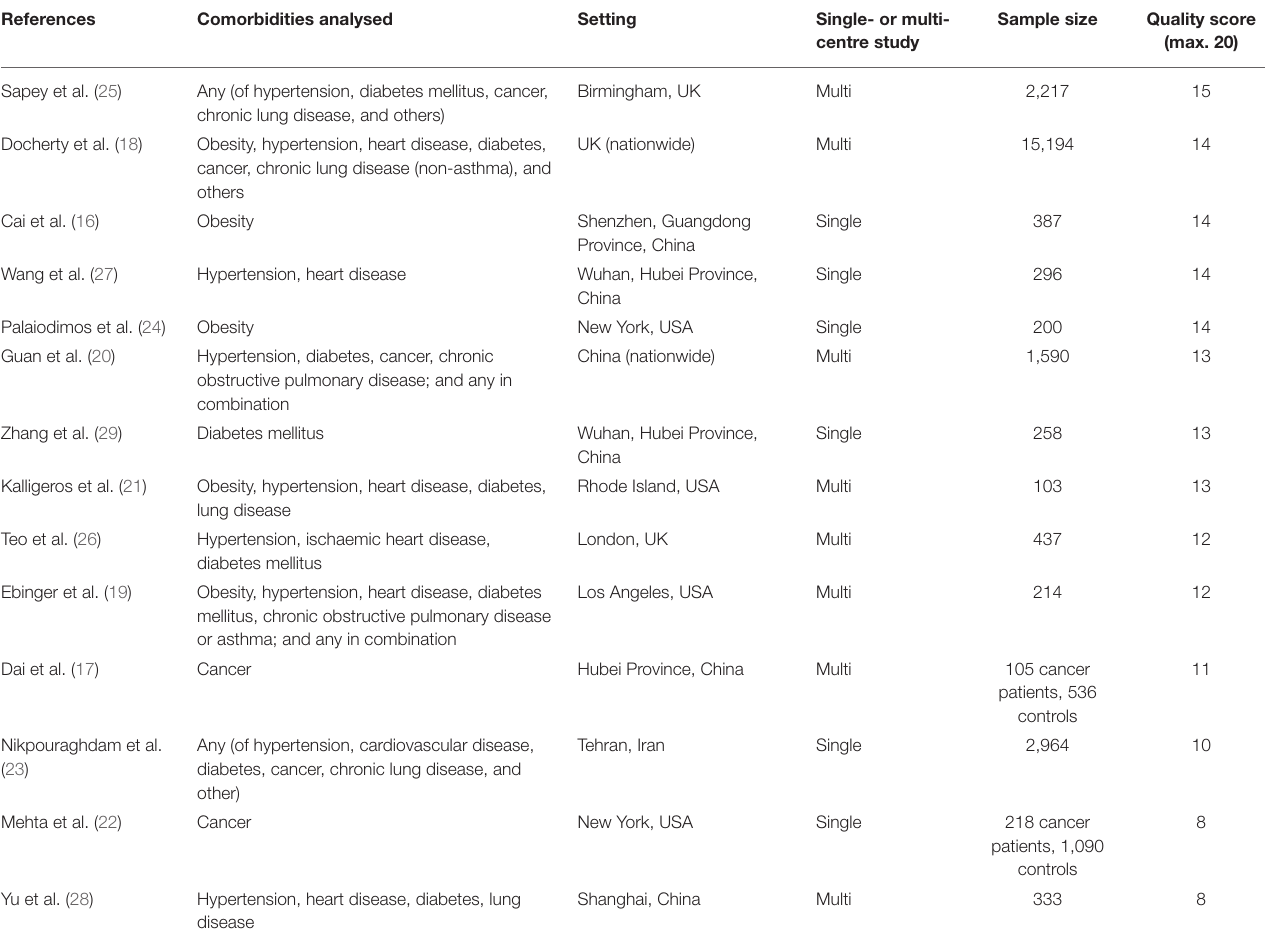
TABLE 2 | Summary of included studies in review of age-adjusted associations between comorbidity and outcomes of COVID-19 in the early stages of the